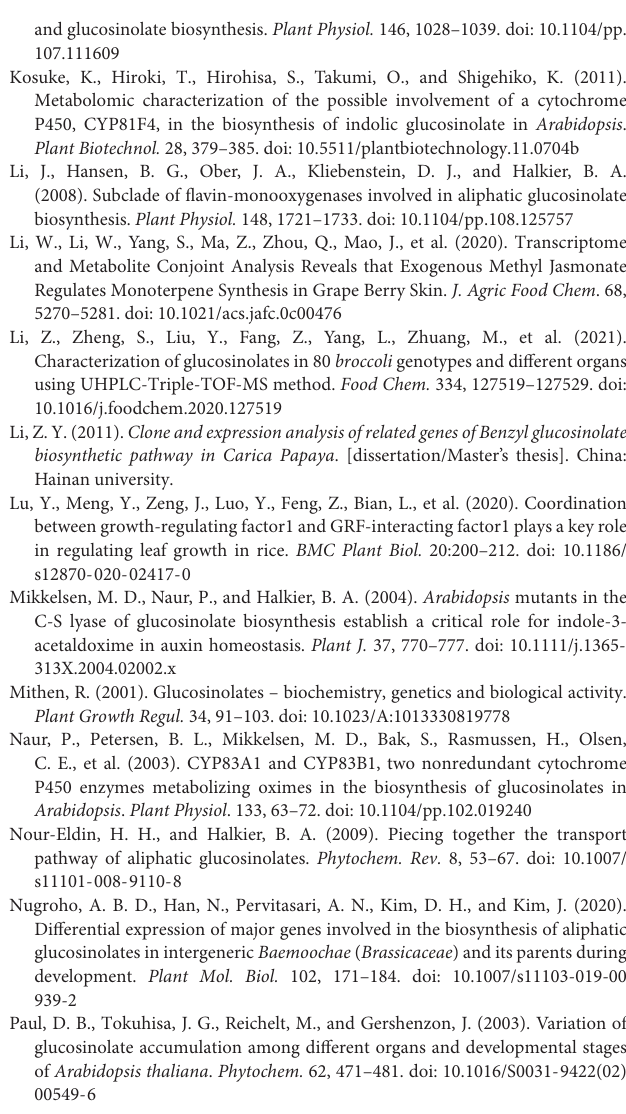
Supplementary Figure 1 | Correlation heat map of RNA sequencing data across the 3 biological replicates. L, Leaf; S, Stem; B, Bud. Yellow to red in the heat map represents the correlation coefficient from low to high. Supplementary Figure 2 | Heat map of correlation between DEG’s expression levels and glucosinolate content. Blue, white, and red in the heat map represent the correlation index r from low to